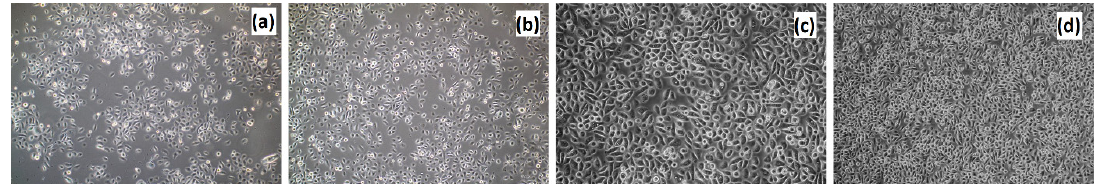
Figure 17. Cell culture of VK2/E6E7 cells on the poly(propylene) mesh—commercially applied biomaterial for pelvic organ prolapse (POP) treatment. ( a ) Poly(propylene) mesh placed in the hole; and ( b ) VK2/E6E7 cells adhered to the bottom of the multi-hole plate.